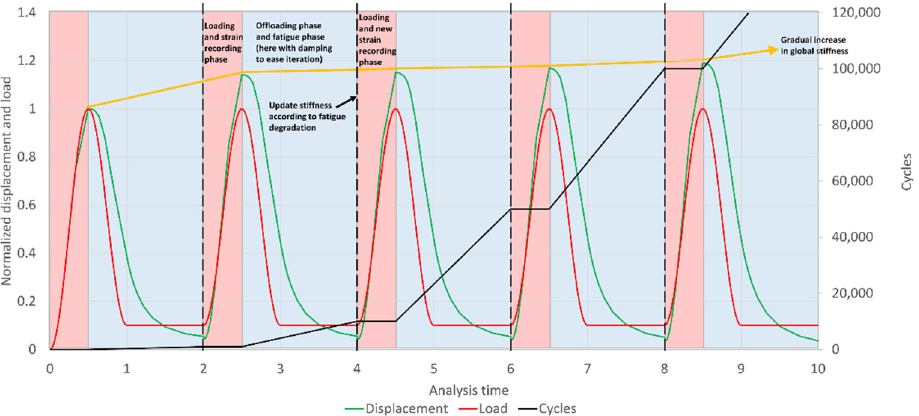
Figure 10. Schematic curves showing how the stiffness changes according to fatigue damage based on the peak strain in each in-tegration point based on the past cycle